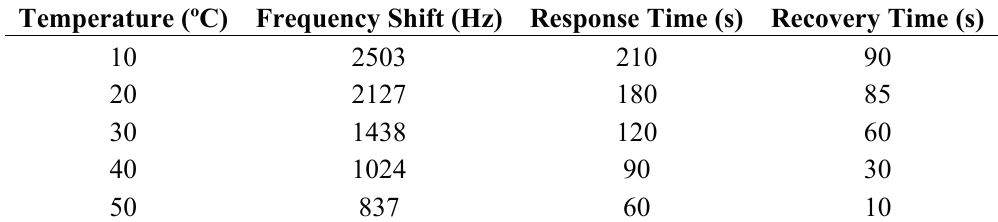
Table 2. Detection results of the SAW-MIP sensor to GB under different temperatures.